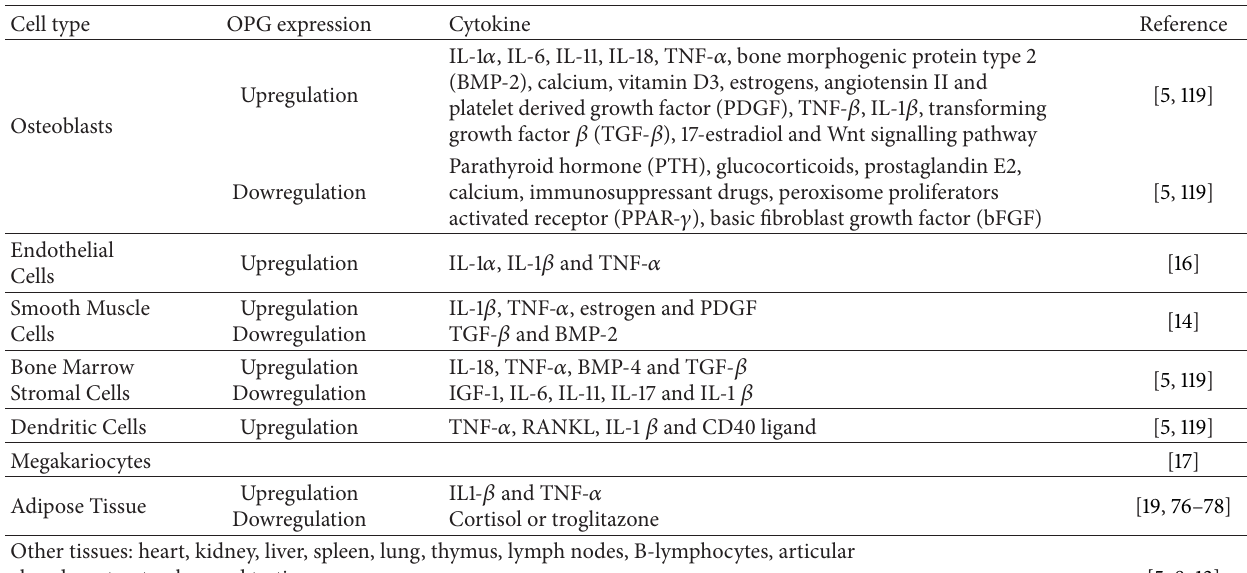
Table 1: Osteoprotegerin expression and regulation in different